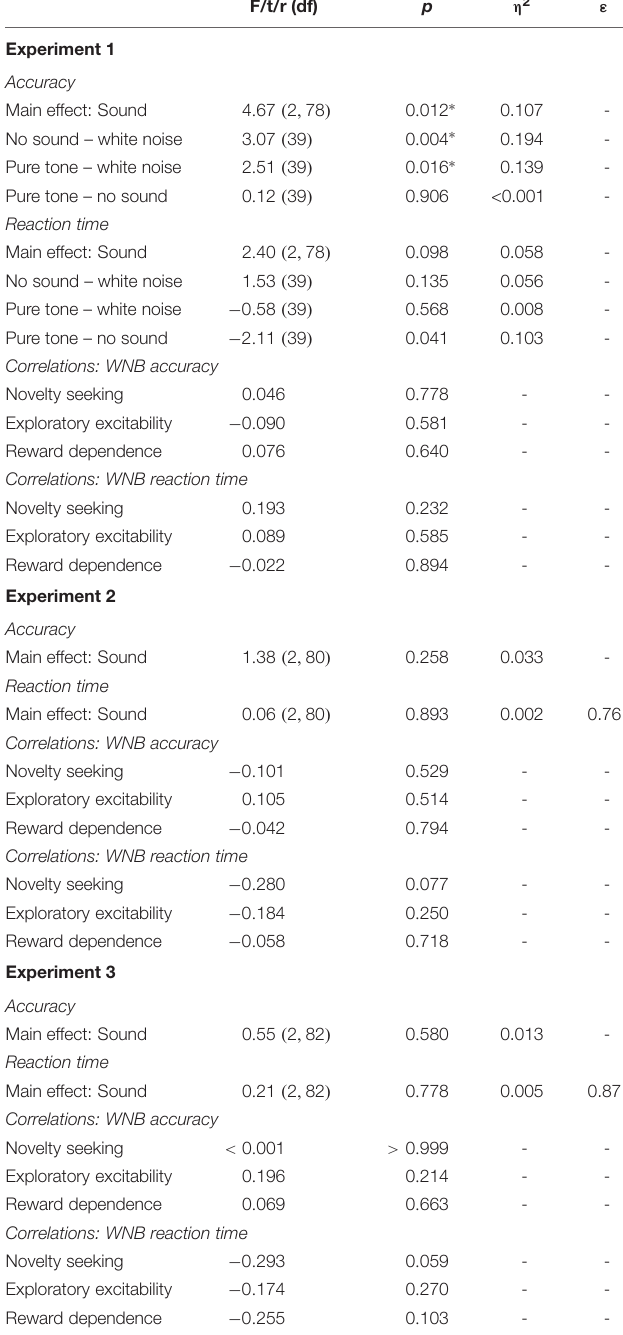
F-values for the ANOVA, t-values for direct comparisons and r-values for correlations are given. p-values are marked with an asterisk whenever considered significant. ε -values are given for Greenhouse–Geisser correction. WNB, white noise